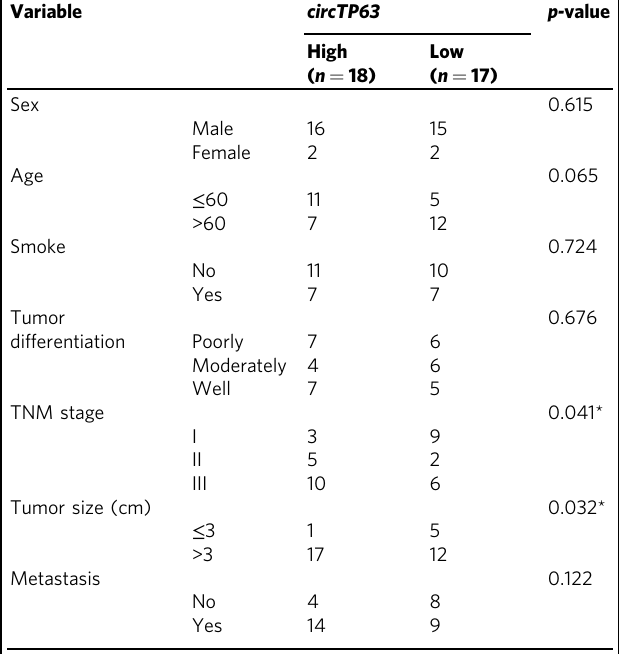
Table 1 The relationship of circTP63 and